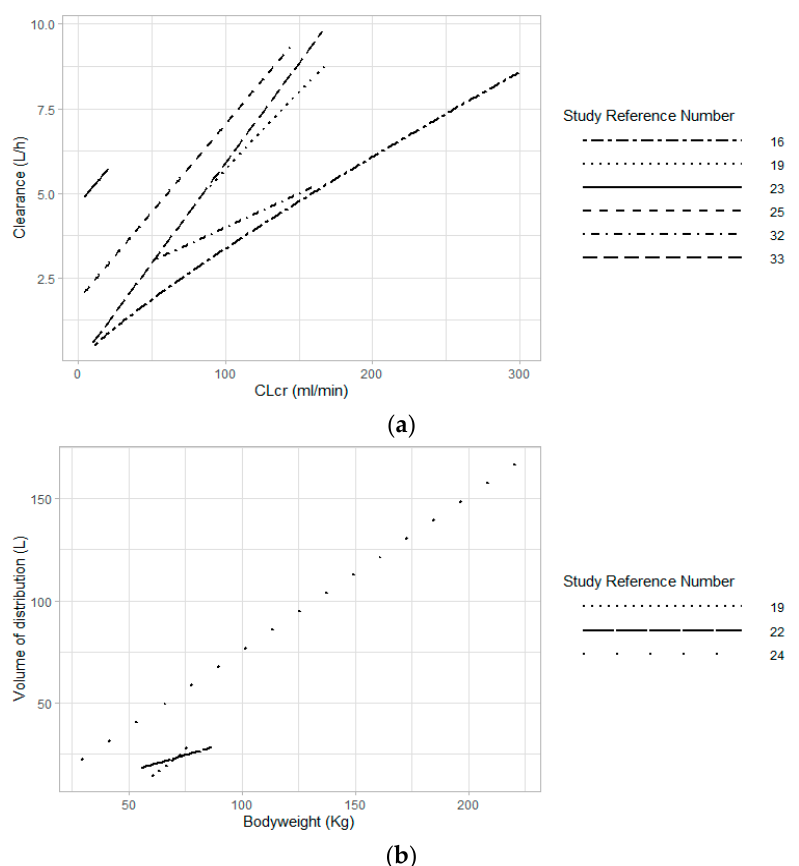
Figure 3. ( a ) Aminoglycoside clearance values against range of creatinine clearance in the respective studies. ( b ) Aminoglycoside volume of distribution values against range of bodyweight in the respective studies. Note: Two studies used IBW [19,26] and one used TBW [24] in their model.